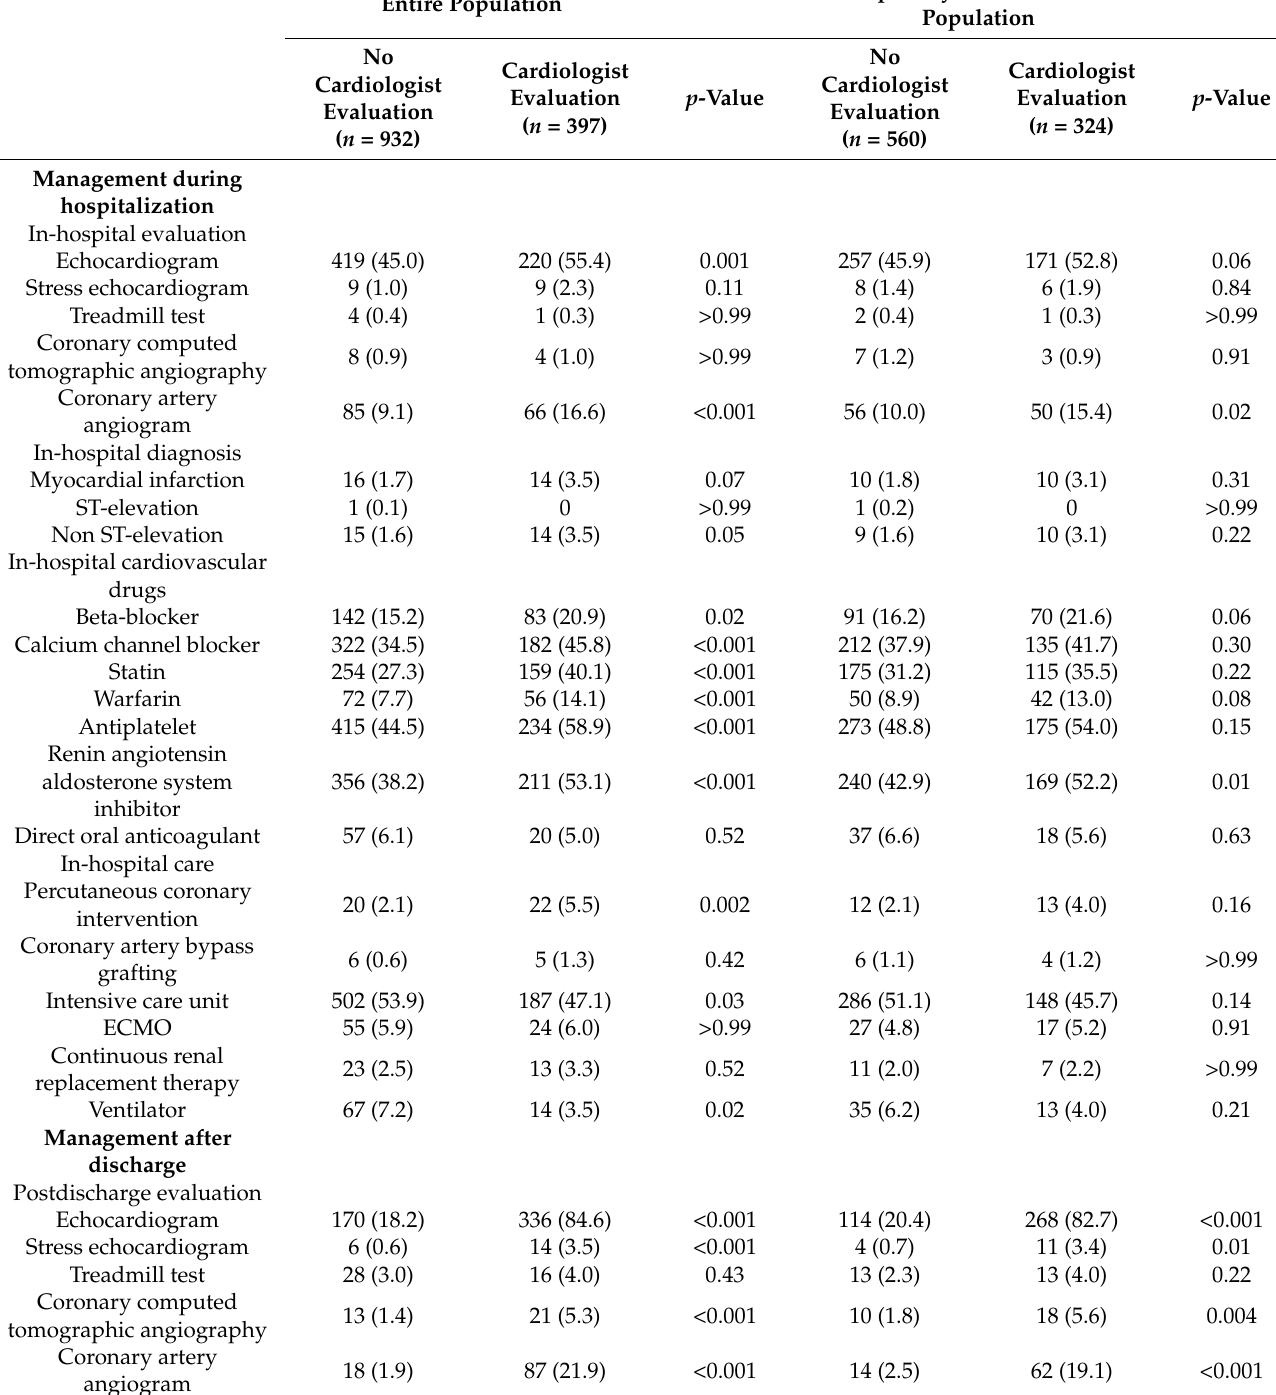
Table 3. In-hospital and postdischarge